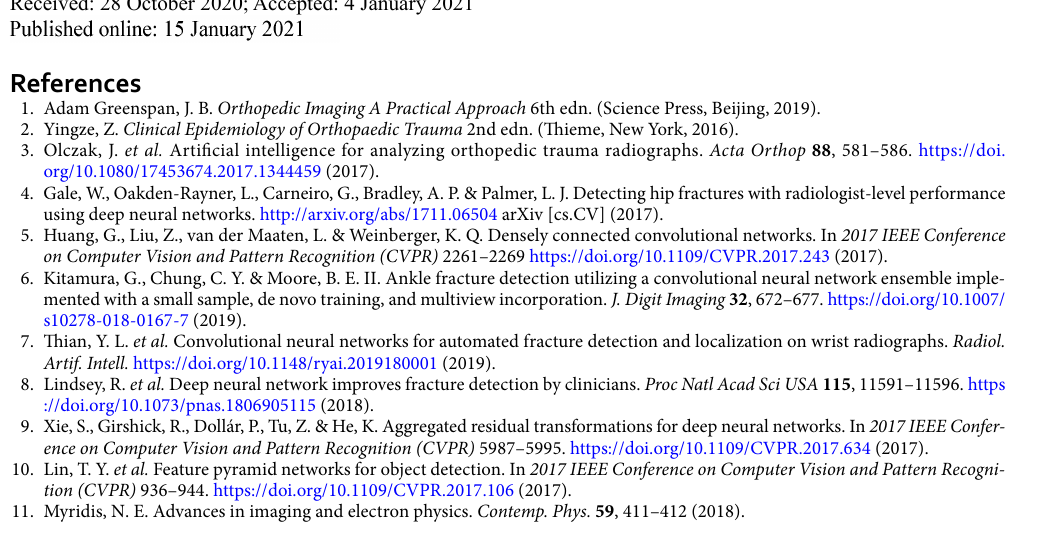
True Positive Precision = True Positive + False Positive